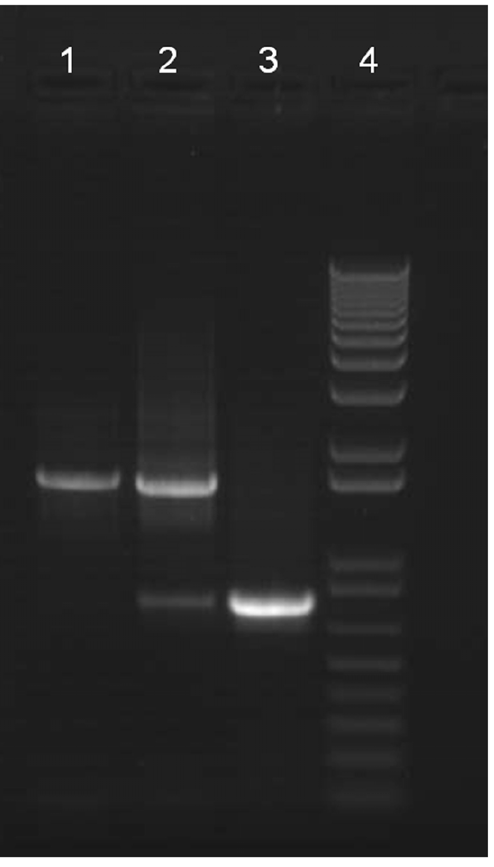
Figure 2. Gel electrophoresis analysis of nad5 D mtDNA. C. briggsae DNA samples were analyzed by PCR using primers flanking the nad5 D locus. Resultant PCR products were subject to agarose gel electrophoresis and scored according to the PCR band genotypes described in the Results. Lane 1 shows a sampled scored as intact (large band only); lane 2 shows a sample scored as intermediate (both large and small bands); lane 3 shows a sample scored as deletion (small band only). Lane 4 shows the molecular marker (1 kb + DNA ladder).